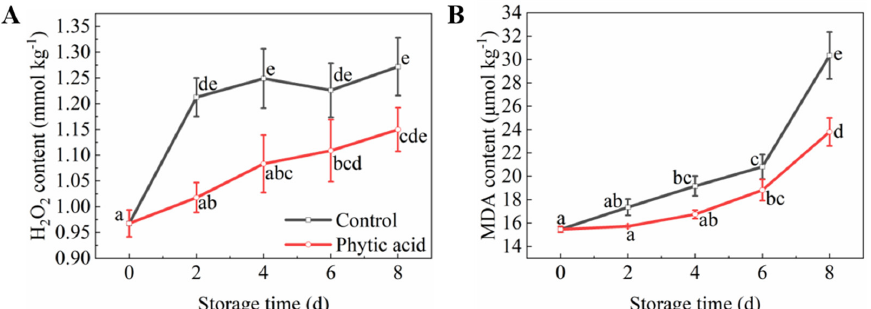
Figure 4. Membrane damage indicators of fresh-cut apples during storage after treatment with phytic acid or the control. ( A ) H 2 O 2 content; ( B ) MDA content. Vertical bars represent standard errors of the means of three replicates. The different letters indicate significant differences at p < 0.05.